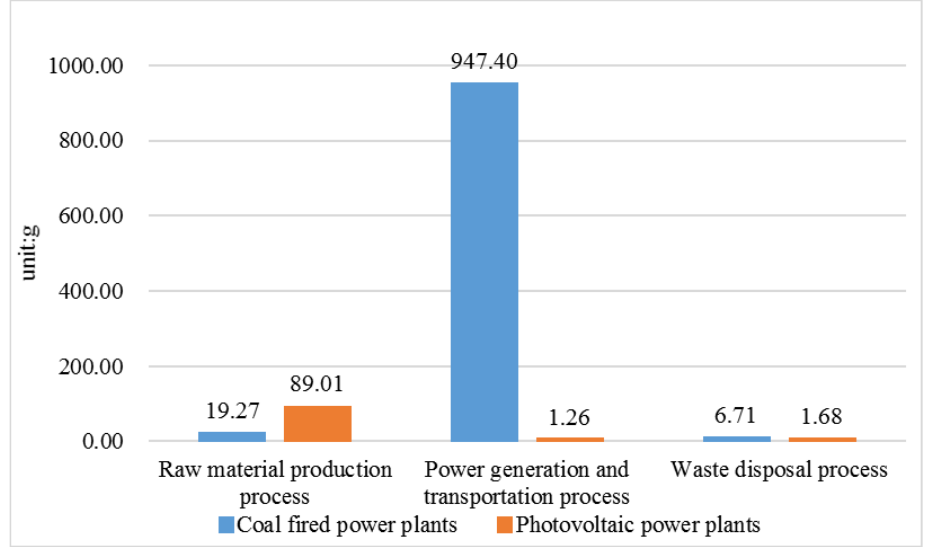
Figure 3. Comparison of CO 2 emissions from coal-fired power generation and photovoltaic power generation.